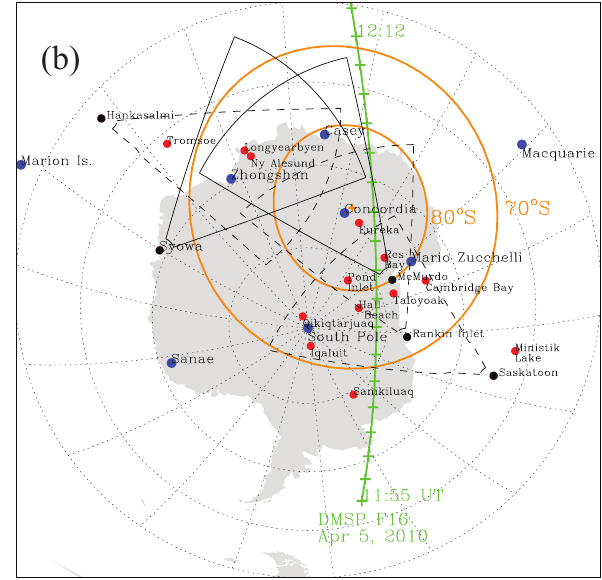
Fig. 1b. GPS scintillation receivers in Antarctica (blue dots) and the field of view of the SuperDARN radar in McMurdo and Syowa East. Conjugate locations of northern GISTM arrays (red dots) and fields of view of Saskatoon, Rankin Inlet and Hankasalmi SuperDARN radar (dashed line) are superposed. Radar locations are shown by black dots. Corrected geomagnetic (CGM) latitudes 70 ◦ S and 80 ◦ S and DMSP F16 satellite track are